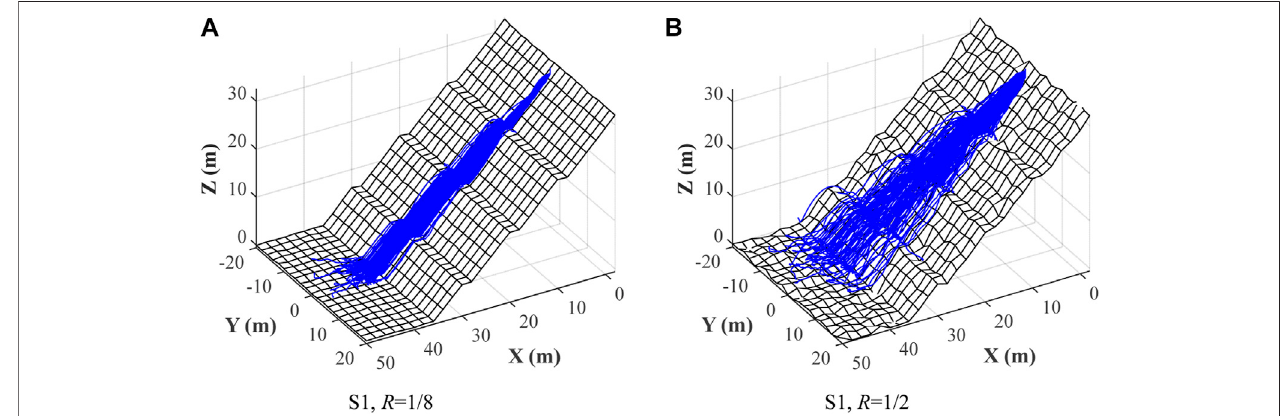
FIGURE 11 | Model results for a case with different rock block sphericities: (A) runout distance; (B) lateral displacement; (C) maximum velocity; and (D) maximum jumping height.